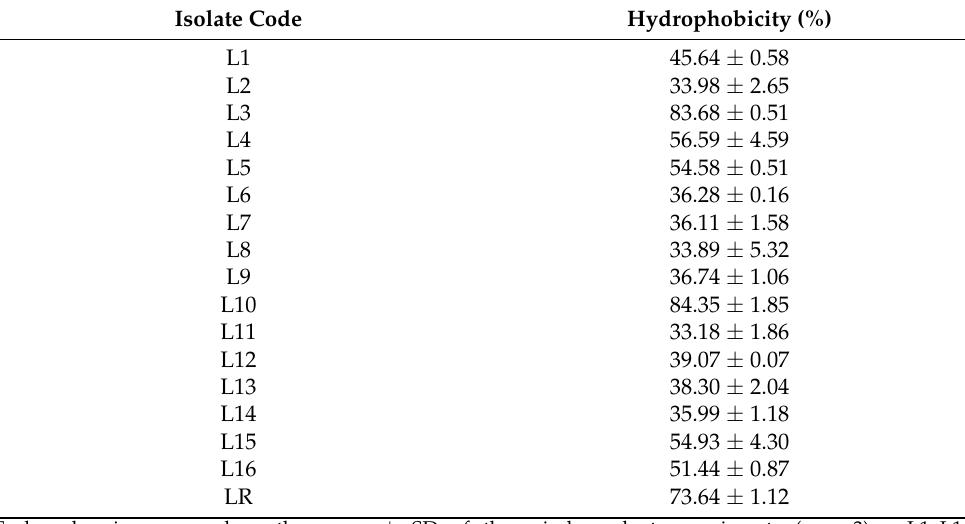
Table 2. Hydrophobicity (%) of Leuconostoc mesenteroides subsp. mesenteroides strains to ethyl acetate, measured as OD 600nm .